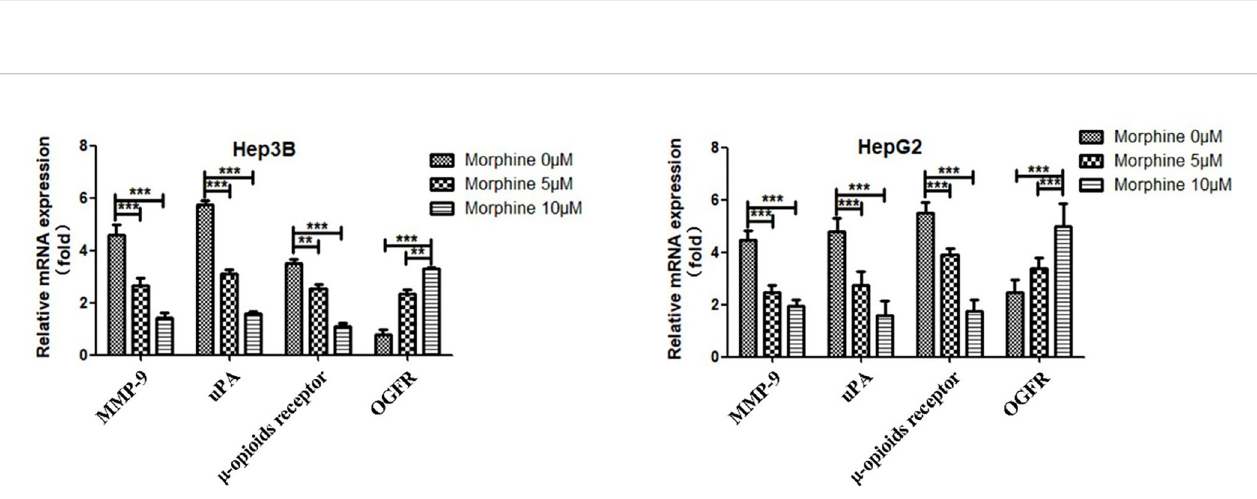
FIGURE 7 | Liver cancer cells were pretreated with different concentrations of morphine (0,5,10 m M) for 24h followed by qRT-PCR to detect the mRNA level of OGFR , MOR , uPA and MMP-9 in Hep3B/HepG2 cells. Data are expressed as mean ± SE; n=3. ** P < 0.01, *** P <